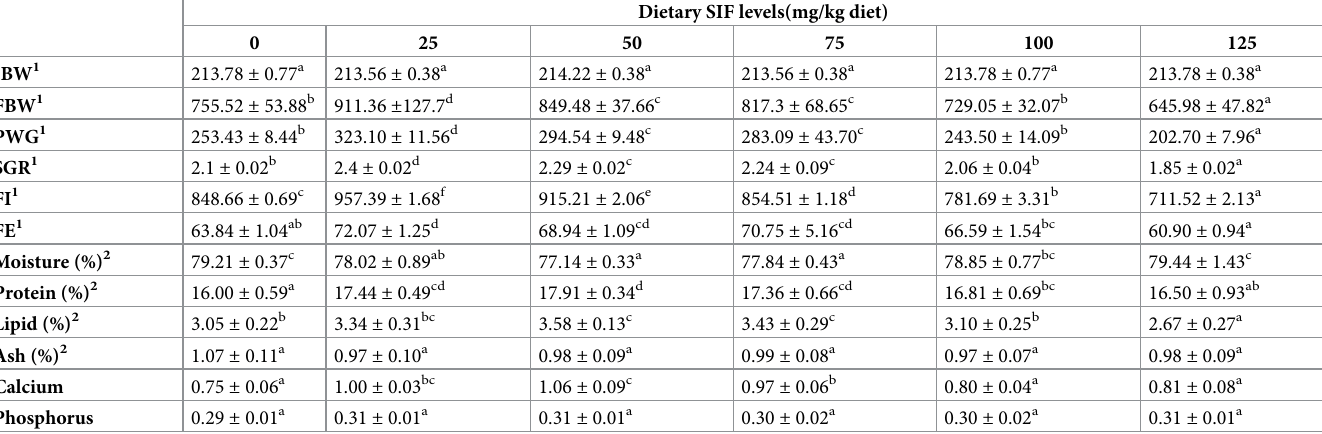
Table 3. Growth performance and muscle composition of grass carp fed the diets with graded level of SIF for 60 days 1 .